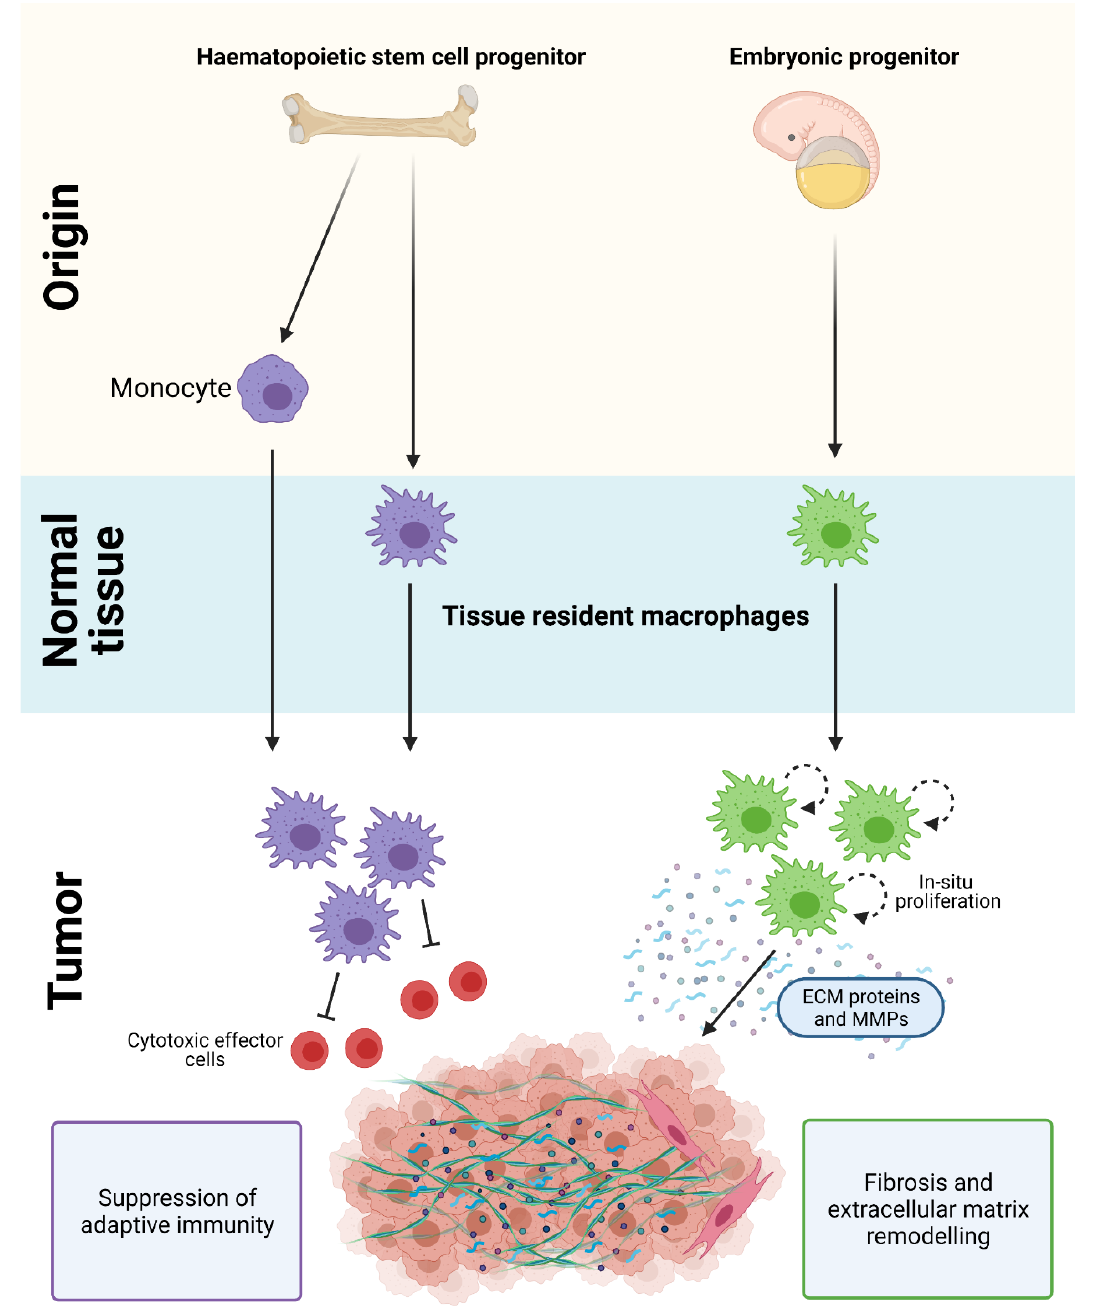
Figure 1. Origin of macrophages in PDAC. Macrophages in PDAC are derived from a mixed population of tissue-resident cells and circulating monocytes. HSC/monocyte-derived macrophages play a key role in regulating immune suppression and adaptive immunity, while embryonically-derived macrophages are important in promoting fibrosis and extracellular matrix remodeling in PDAC. Figure created in Biorender.